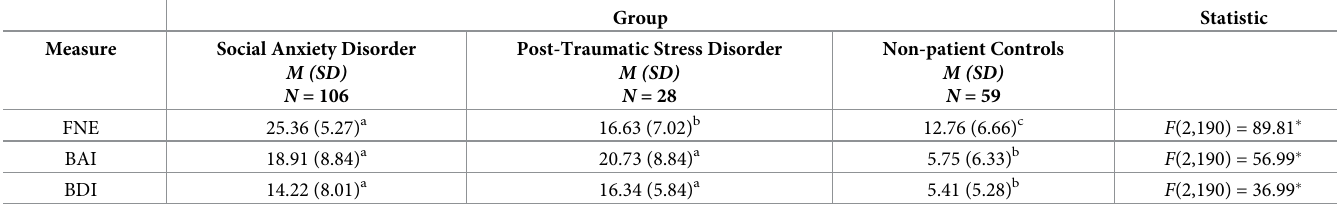
Table 1. Differences in social anxiety (FNE), general anxiety (BAI), and depression (BDI) between SAD, PTSD and non-patient groups. Group Statistic Measure Social Anxiety